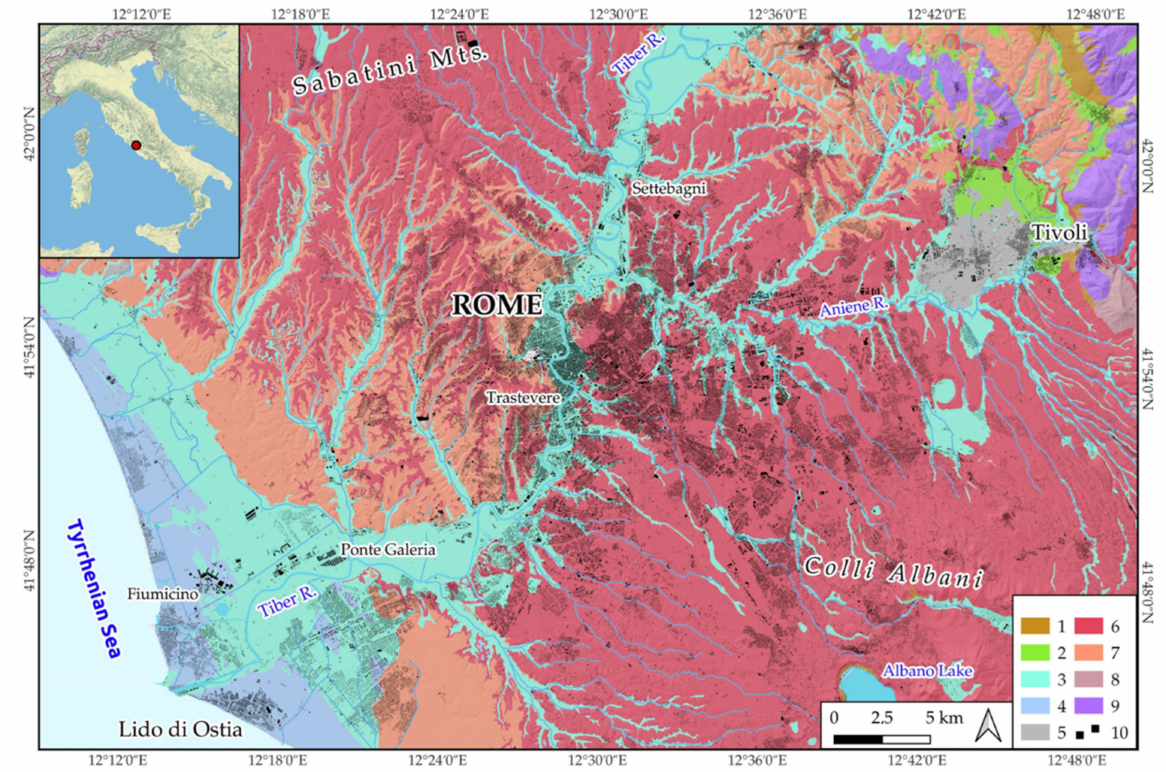
Figure 5. Geological sketch map of the Urban area of Rome and surroundings (red dot in the upper image), modified from [40]. (1) Slope deposits; (2) Eluvial-colluvial deposits; (3) Alluvial and lacustrine deposits; (4) Coastal deposits; (5) Travertines; (6) Volcanic deposits; (7) Pleistocene marine deposits; (8) Shales, marls, siltites; (9) Limestones; (10)